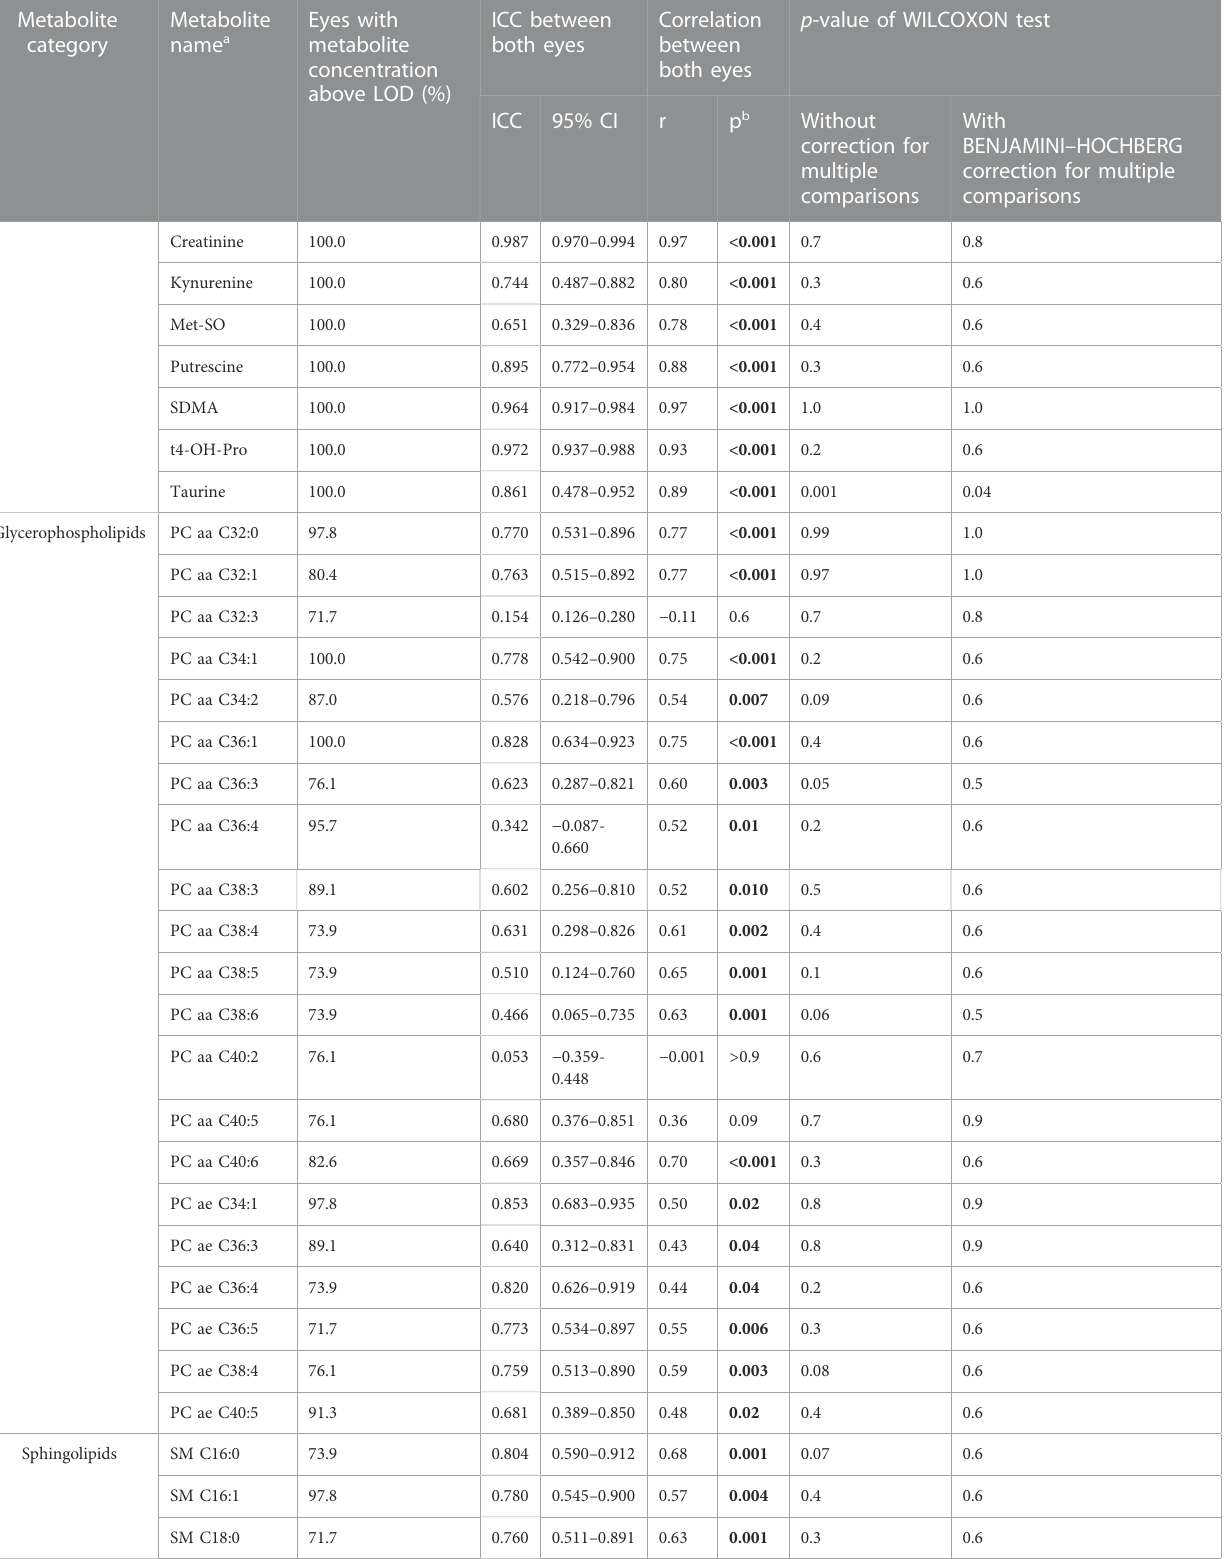
TABLE 3 ( Continued ) Comparison of metabolite concentrations between fellow